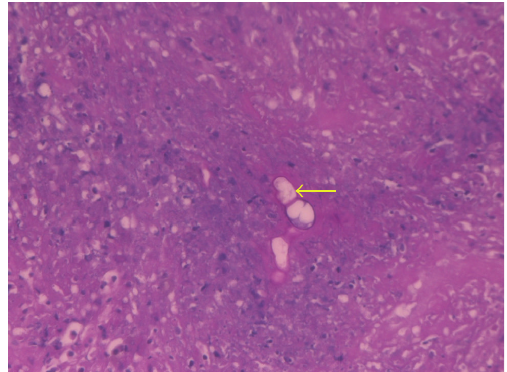
Figure 3: Periodic acid-Schi ff stain showing fungal forms (yellow arrow) surrounded by Splendor-Hoeppli phenomenon in a back- ground of acute suppurative inflammation and necrosis.